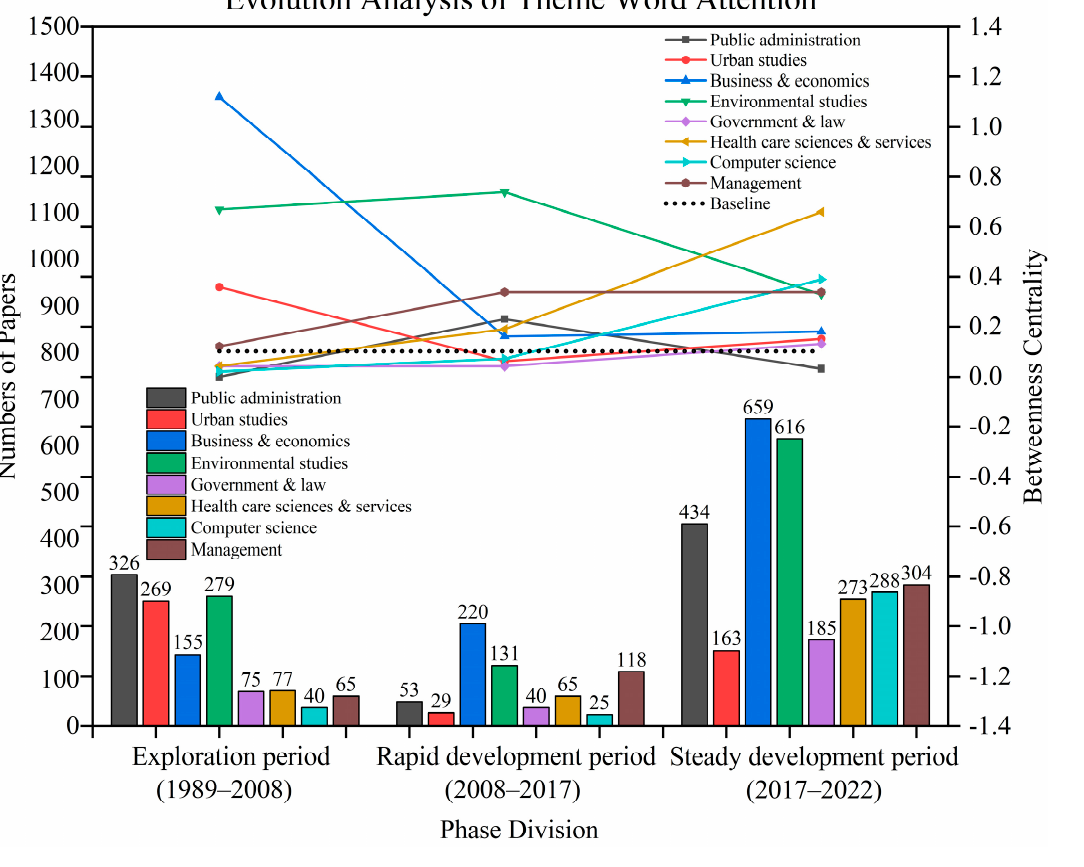
Figure 10. Evolution Analysis of Theme Word Attention.